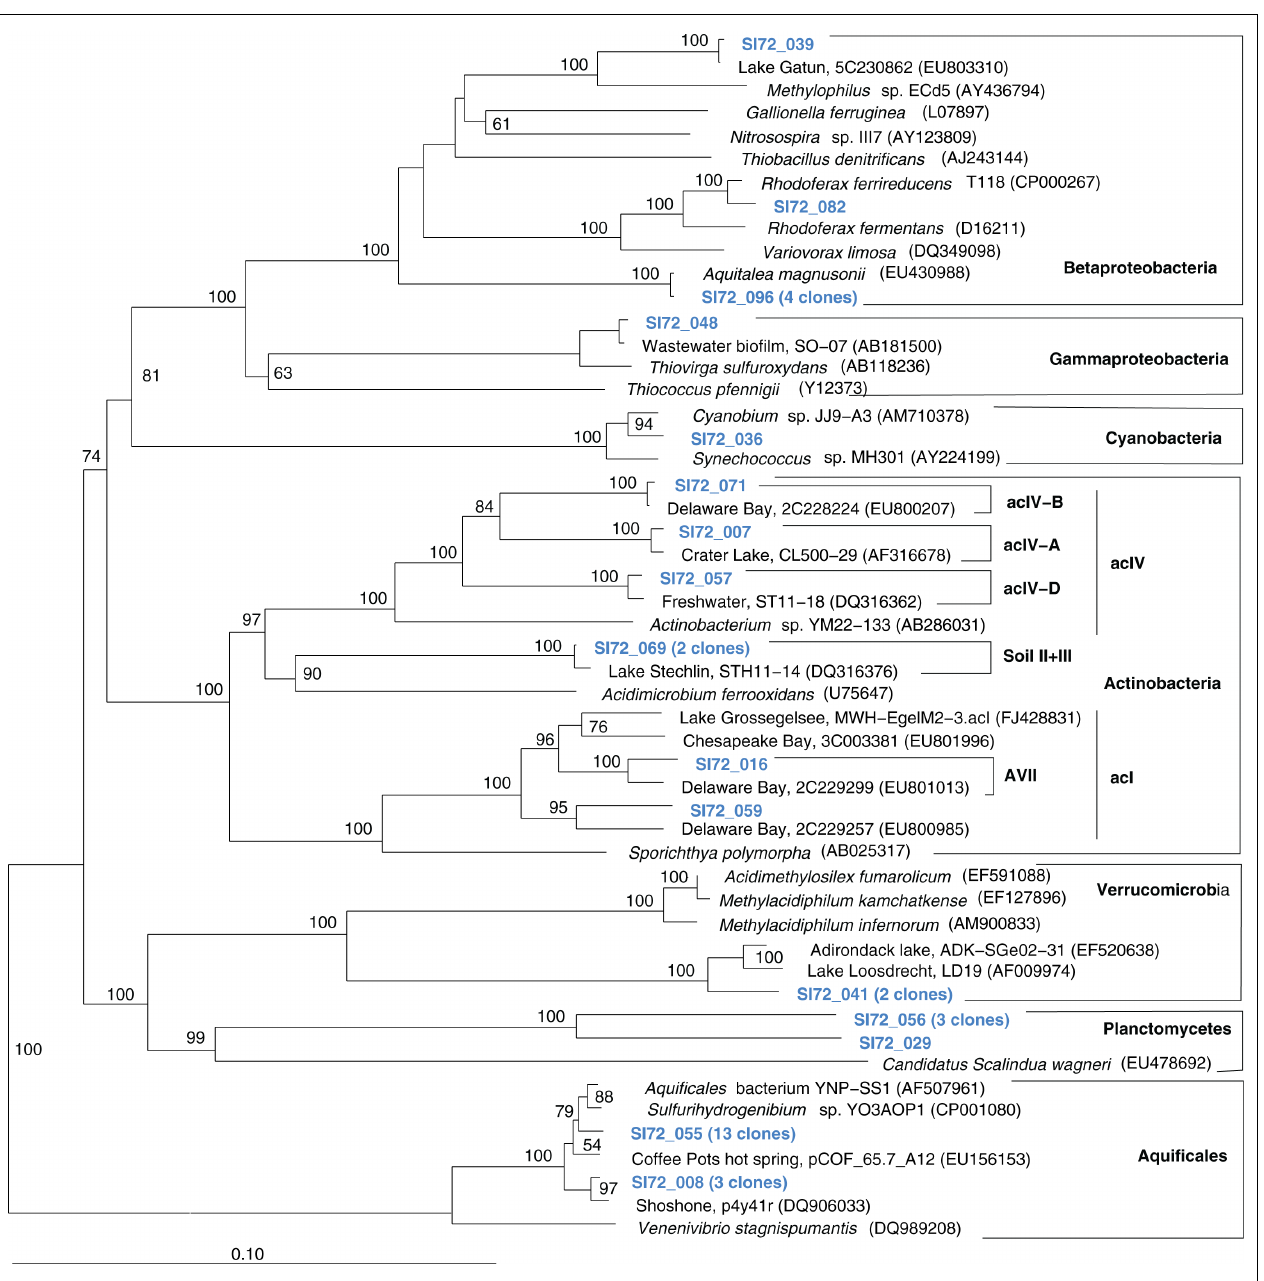
FIGURE 5 | Phylogeny of Stevenson Island 72 bacterial clones, based on E. coli 16S rRNA gene nucleotide positions 25–1491.